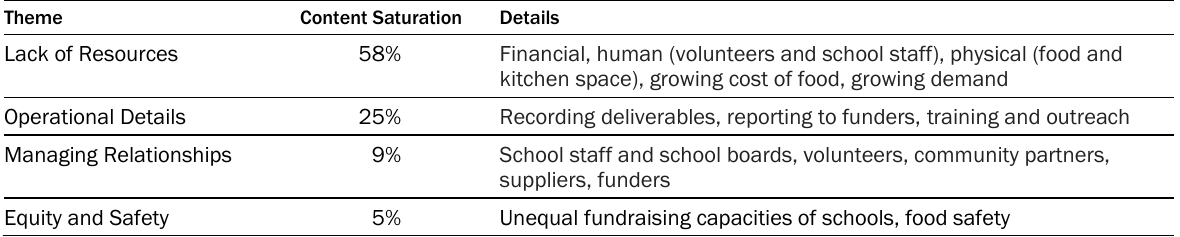
Table 2. Prepandemic SNP